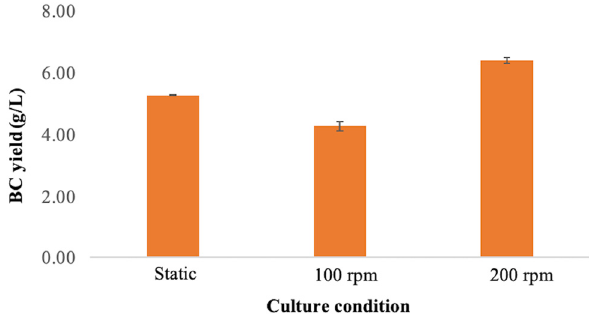
Figure 6: BC yield ( g/L ) produced by P. kudriavzevii USM - YBP2 at 30°C under di ff erent culture conditions; static culture, agitation of 100 and